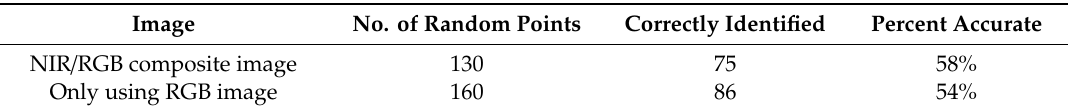
Figure 8. UAV imagery shows the study area in the Manila Dunes ( A ) and compares the results of pixel-based supervised maximum likelihood vegetation classification using only RGB orthoimage ( B ) with the results of same supervised classification methods; however, incorporating a NIR band and texture from the normalized difference vegetation index (NDVI) ( C ). The green features in Figure 8B are mixed conifer forest, and the purple features are invasive mat vegetation. Table 2. Supervised classification accuracy assessment on the normalized di ff erence vegetation index Table 2. Supervised classification accuracy assessment on the normalized difference vegetation (NDVI) NIR image and the RGB index (NDVI) NIR image and the RGB image.